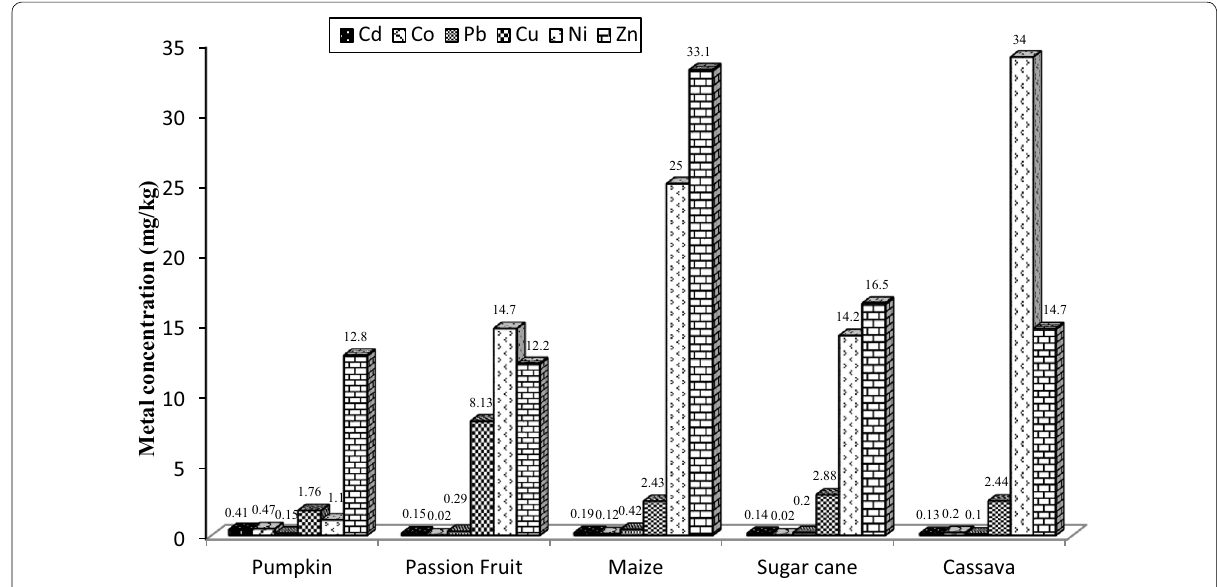
Fig. 2 Average concentrations (mg/kg) of metals in edible part of